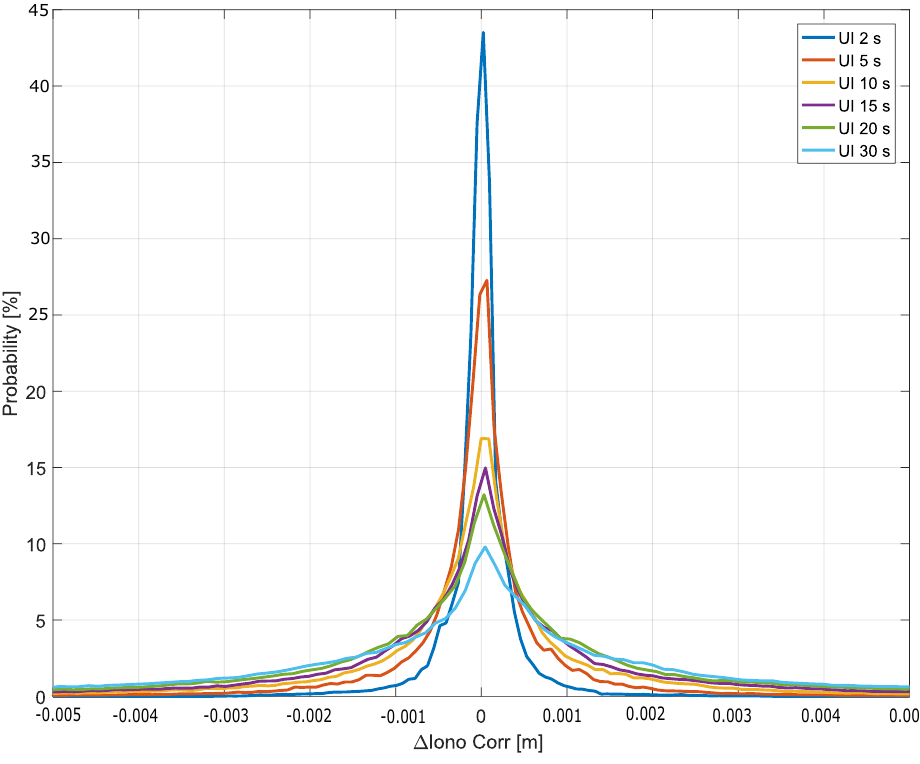
Figure 5. Empirical histograms of the ionospheric correction differences for different update intervals. Histograms have been represented with continuous lines to allow the superposition of different curves. In the legend, “UI” stands for “Update Interval”. The histograms have been computed considering epochs without updated